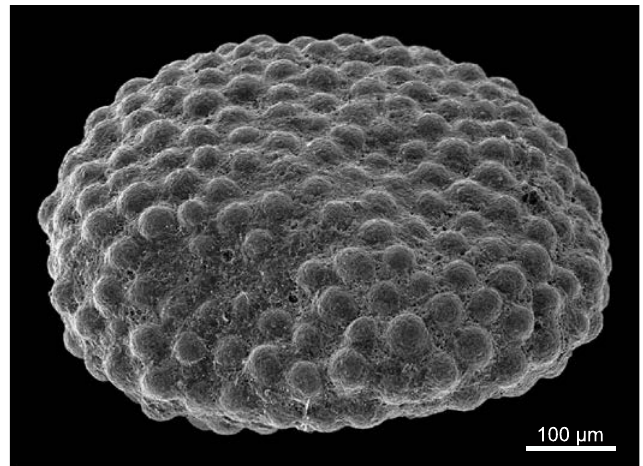
Fig. 34. Pyrite framboid from Lago Antorno, northern Italy, Cassian For- mation, Carnian, Upper Triassic. PZO